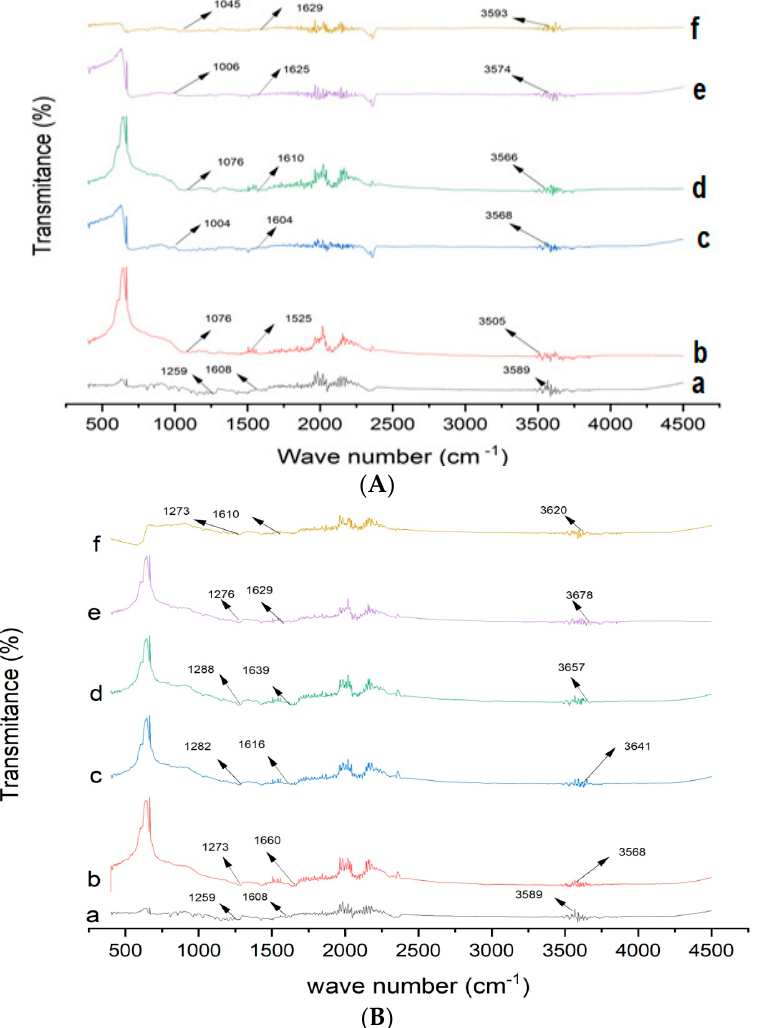
Figure 4. ( A ) FTIR spectra of (a) curcumin, (b) HPMC E5, (c) CUR:HPMC E5 1:2KN, (d) CUR:HPMC 1:4 KN, (e) CUR:HPMC 1:2 SE, and (f) CUR:HPMC 1:4 SE. ( B ). FTIR spectra of (a) pure curcumin, (b) PVP K30, (c) CUR:PVP K30 1:2 KN, (d) CUR:PVP K30 1:4 KN, (e) CUR:PVP K30 1:2 SE, and (f) CUR:PVP K30 1:4 SE.